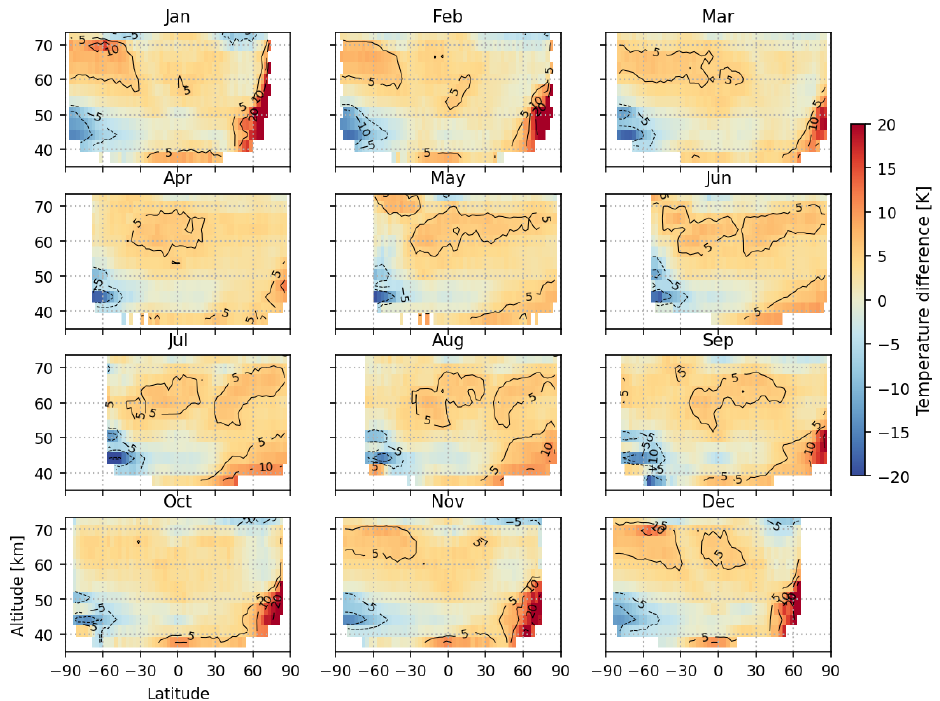
Figure 16. Monthly mean biases between temperature retrieved from O 2 1 (cid:49) airglow in nominal limb orbits and the MIPAS nominal mode temperature. MIPAS temperature in the same orbit is first interpolated to the latitude and altitude of SCIAMACHY layers. The longitudinal difference is neglected. The comparison should be limited to below 70km, which is the maximum height for MIPAS nominal mode.